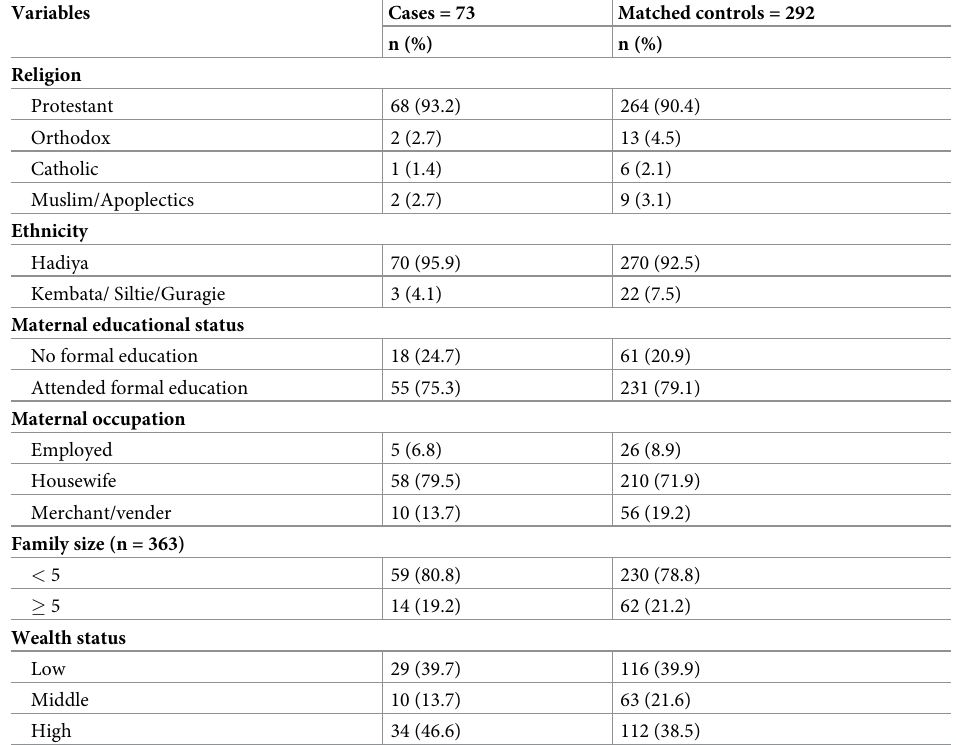
Table 1. Socio-demographic and economic variables of the participants in urban South Ethiopia, July 2019-Sep- tember 2020.